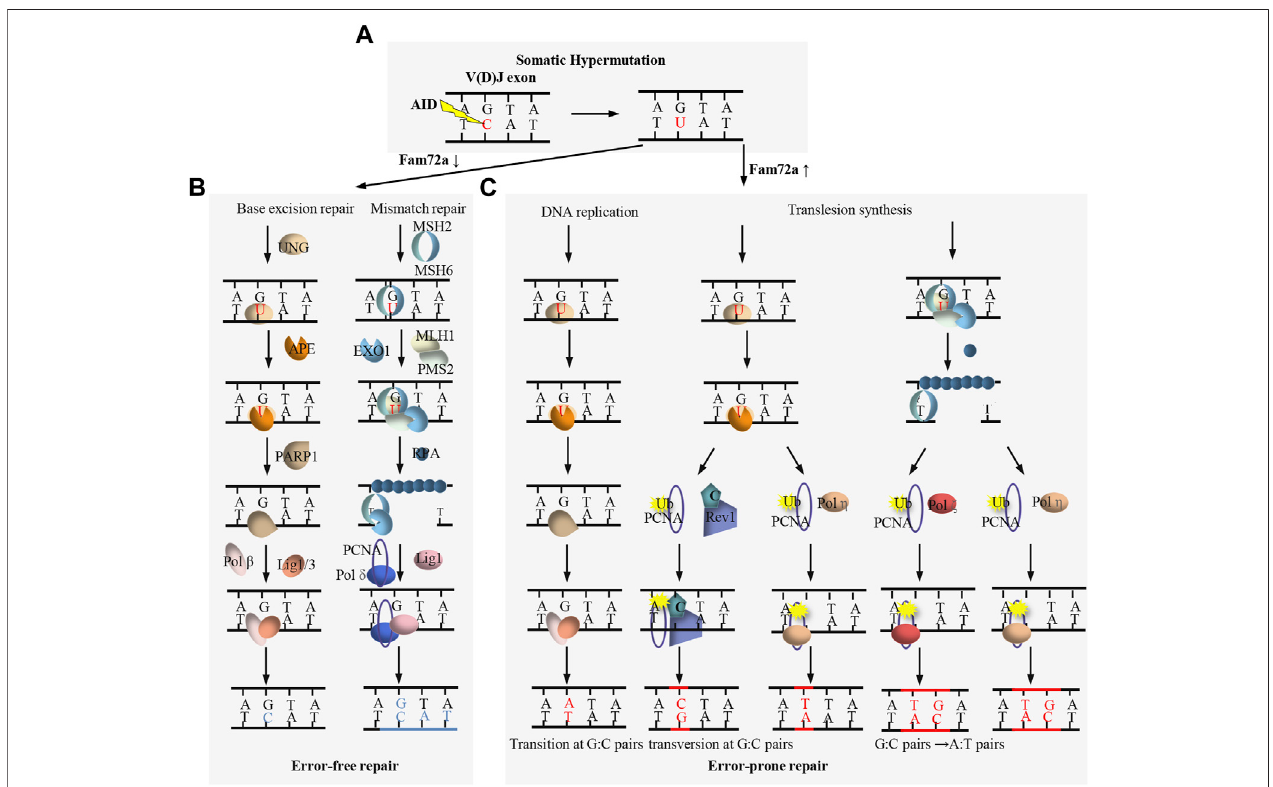
FIGURE3| OverviewofDNAdamagerepairprocessduringSHM. (A) AIDtargetsthedCtogeneratedUwithinV(D)Jexon. (B) FAM72adownregulation promotes baseexcisionrepair(BER)-andmismatchrepair(MMR)-mediatederror-freeDNArepair. (C) FAM72aupregulationpromotesBER-andMMR-mediatederror-proneDNA repair, leading to the mutation of V(D)J exon during